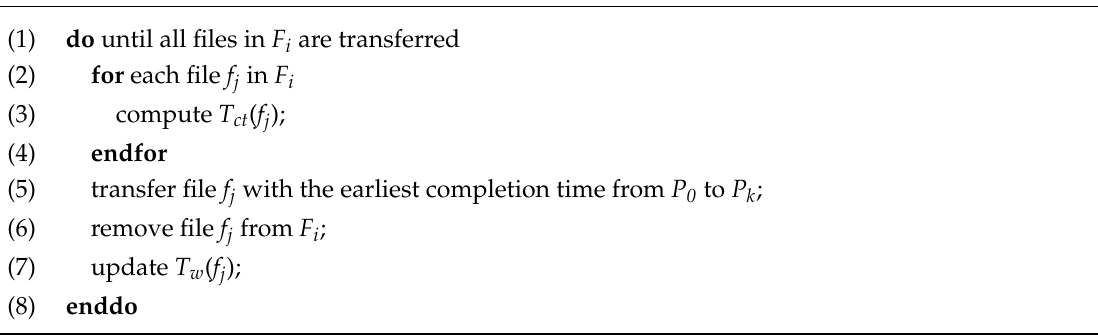
Algorithm 2 The file transmission heuristic in each